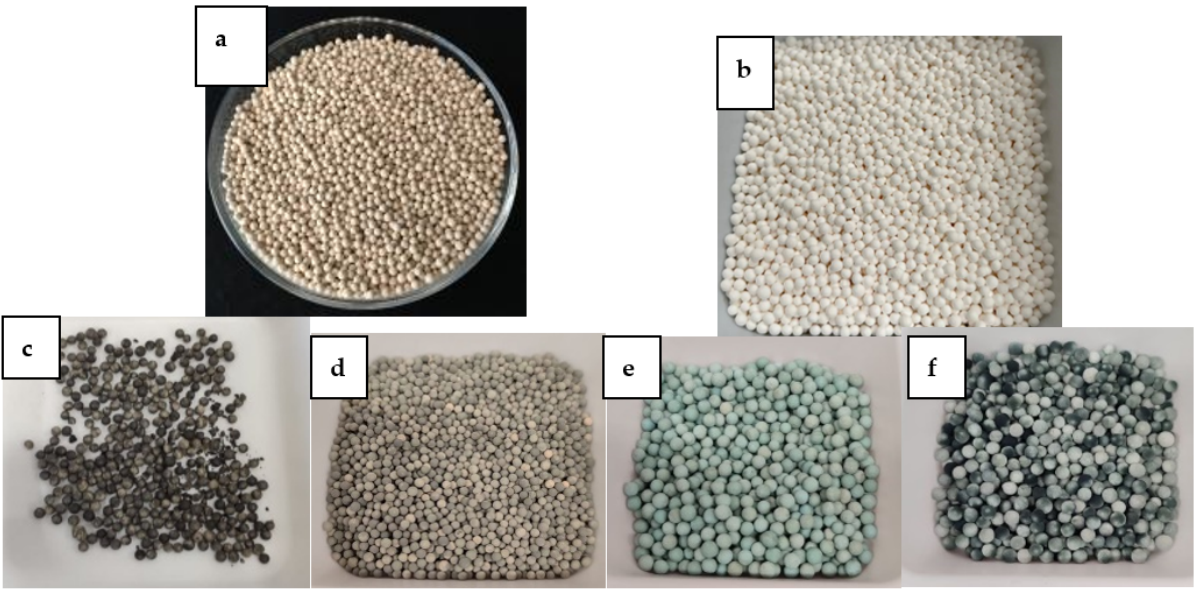
Figure 2. ( a ) Zeolite 13X, ( b ) γ Al 2 O 3, ( c ) 10%wt. Ni-Zeolite13X, ( d ) 0.5%wt. Ru-Zeolite13X, ( e ) 10%wt. Ni- γ Al 2 O 3v , ( f ) 0.5%wt. Ru- γ Al 2 O 3